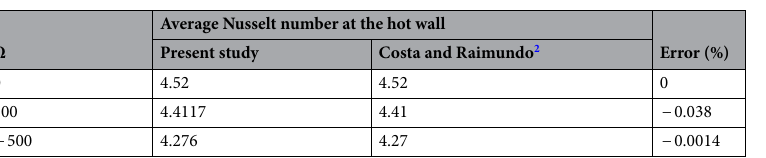
Error (%)Present study Costa and Raimundo 2